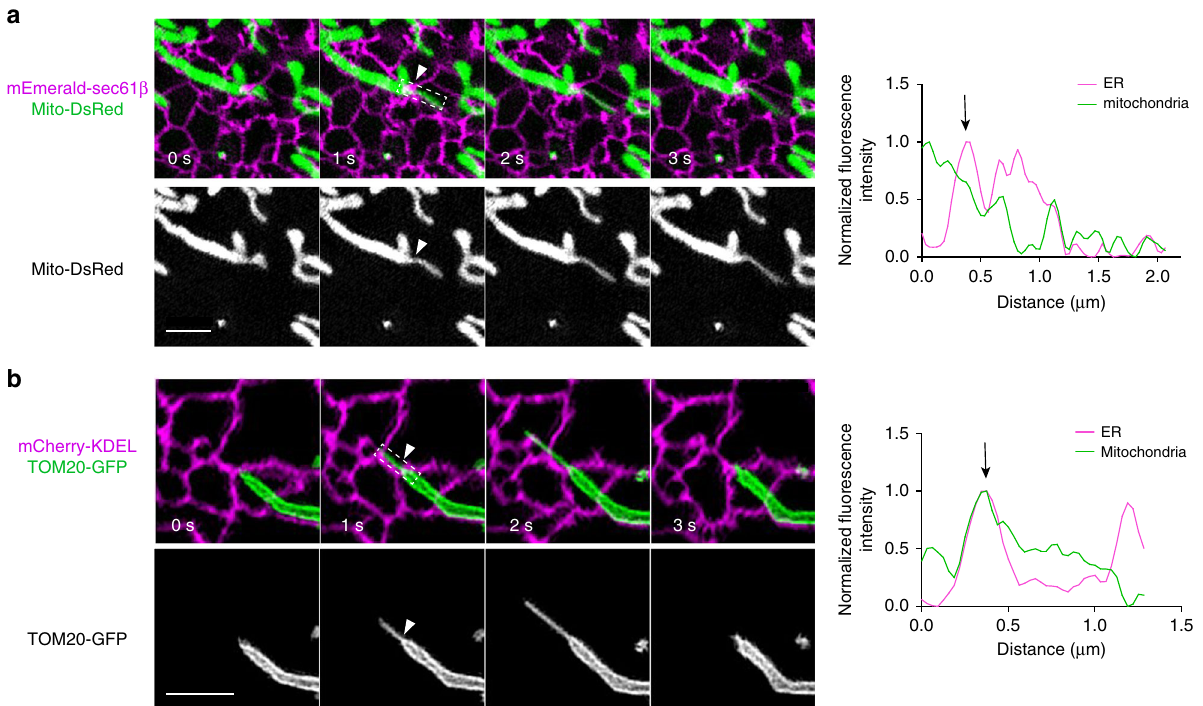
Fig. 2 ER tubules mark the initiation sites of MDT. a , b Examples of MDT at ER – mitochondria contacts. Left-hand images show Cos-7 cells expressing a mEmerald-Sec61 β and mito-DsRed, and b mCherry-KDEL and Tom20-GFP, merged as indicated. Right graphs are linescans drawn through the mitochondria (dashed box), and show the relative fl uorescence intensity of mitochondria (green) and ER (purple) along their lengths. White arrowheads at constrictions in the images correspond to the black arrows shown on the corresponding linescan graphs. Scale bars: 2 μ m. Additional examples are shown in Supplementary Fig. 5a –